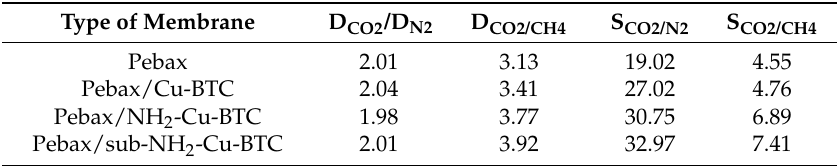
Table 3. Diffusivity and solubility selectivity of CO 2 /N 2 and CO 2 /CH 4 . Type of